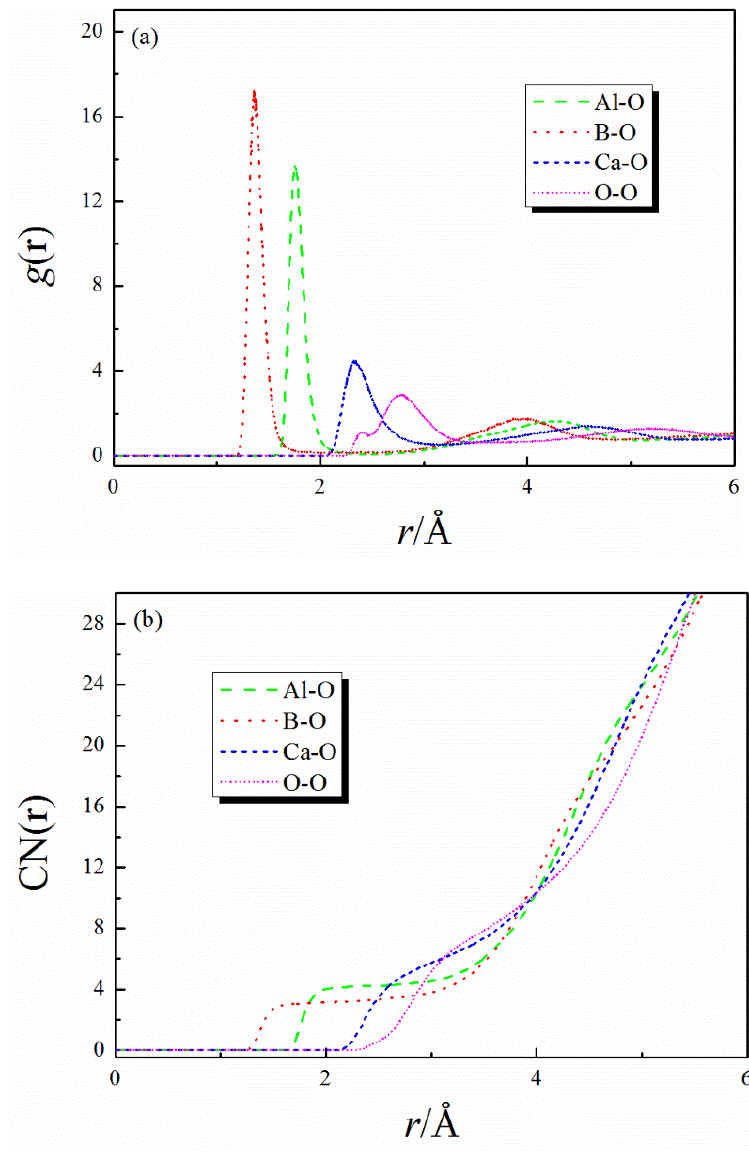
Figure 2. ( a ) RDFs and ( b ) CNs of different particle pairs in CaO – Al 2 O 3 – B 2 O 3 melt.